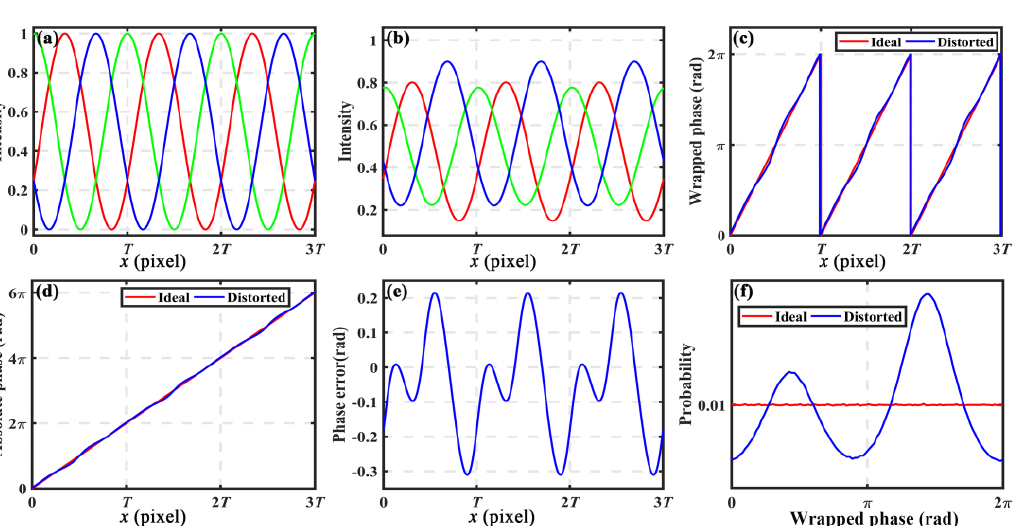
Figure 1. Results regarding different patterns. ( a , b ) Intensity distributions of ideal patterns and distorted patterns, respectively; ( c ) wrapped phases of the ideal pattern and the distorted pattern; ( d ) absolute phases of the ideal pattern and the distorted pattern; ( e ) nonlinear error distribution; and ( f ) phase probability distribution of the ideal and the distorted patterns. In addition, the distorted (cid:101) φ stayed monotonic but became nonlinear within each